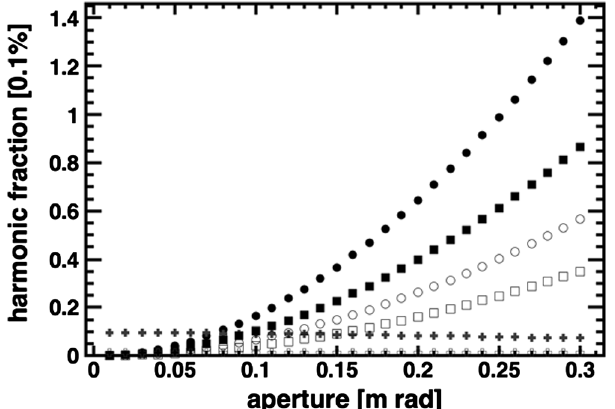
FIG. 8. The spectral density vs the ICS bandwidth for a laser FIG. 10. The fraction of photons emitted on the second pulse energy of U ¼ 400 mJ, (black dots) σ t ; l ¼ 0 . 5 ps, and harmonic (black increasing quadratic curves with aperture) and σ ¼ σ ¼ 7 . 5 μ m, (gray squares) σ ¼ 1 . 25 ps and σ ¼ third harmonic (gray linear decreasing curves with aperture) for a x ; l y ; l t ; l x ; l laser beam with pure circular (full and open squares) or linear (full and open dots or crosses) polarization as function of aperture. They are shown for a U ¼ 400 mJ pulse of σ t;l ¼ 1 . 25 ps and σ ¼ 7 . 5 μ m (full markers), and σ x;l (open markers). The third harmonic contribution is negligible in the σ x;l ¼ 12 . 5 μ m